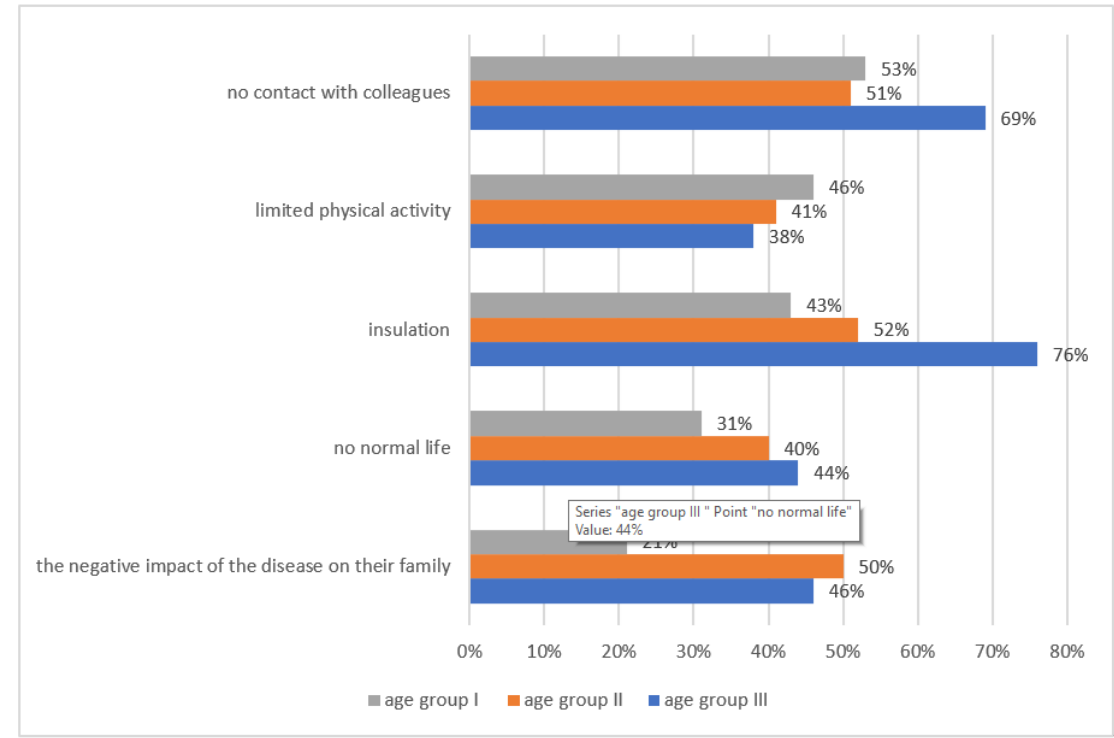
Figure 2. Factors negatively influencing the well-being of the respondents. Table 2. Severity of depression on the Beck scale.